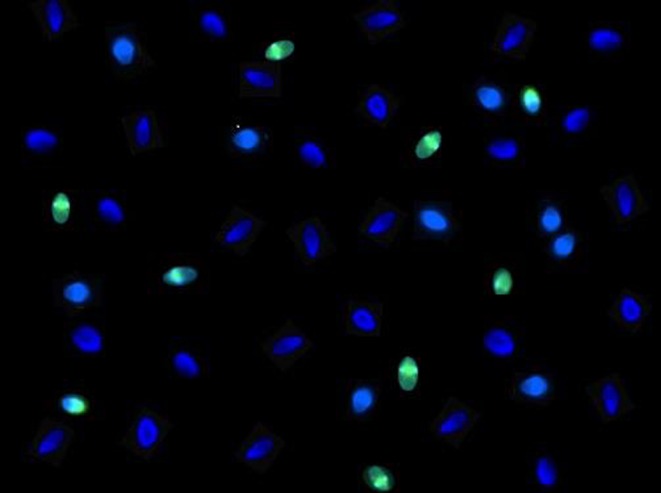
Terminal deoxynucleotidyl transferase dUTP nick-end labeling (TUNEL) immunofluorescent staining of human spermatozoa for detection of DNA fragmentation. Sperm cells which fluoresce green indicate the presence of DNA fragmentation that occurs during the late stages of apoptosis, detected by the action of the TdT enzyme. Spermatozoa are considered TUNEL positive if approximately 40% or more of the head is fluorescent. Spermatozoa without compromised chromatin integrity are shown in blue using DAPI counterstain. Five hundred sperm cells per sample are assessed using fluorescent microscopy in order to determine the sperm chromatin fragmentation, with a threshold of ≤15% TUNEL positivity considered normal.